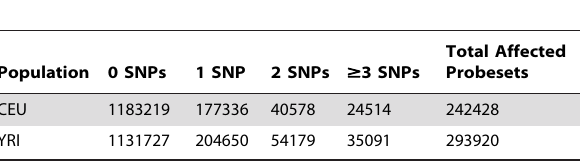
Table 2. Probesets containing common SNPs based on the 1000 Genomes Project data.